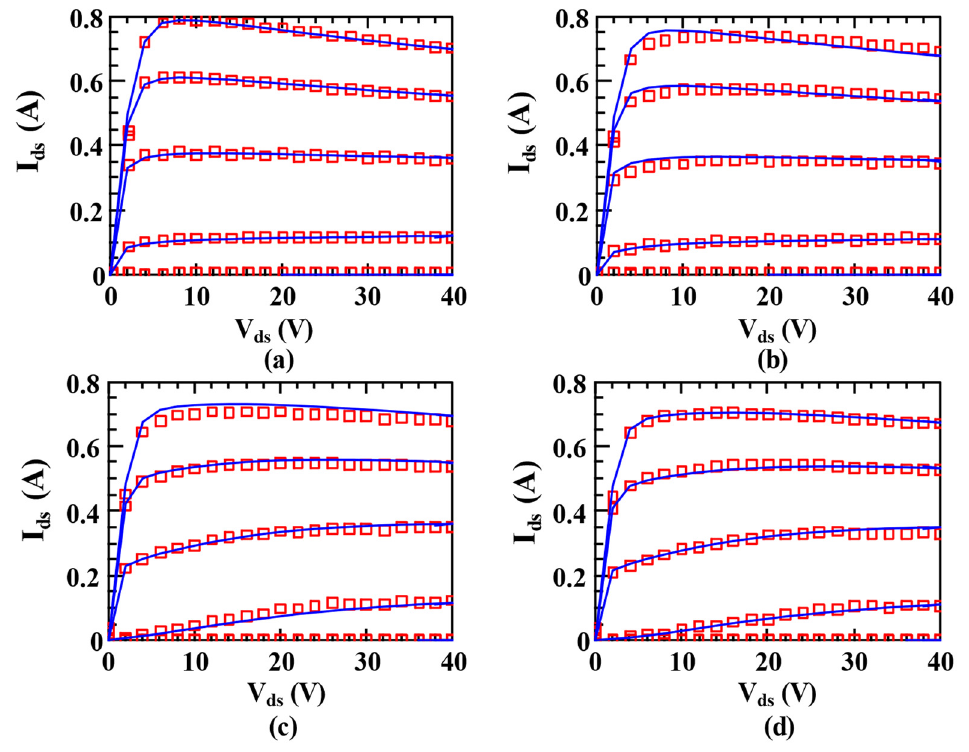
Figure 5. Measured (symbol) pulsed I DS − V DS data and modeled (line) pulsed I DS − V DS data using the trap model proposed in this paper under different quiescent bias at 25 ◦ C: ( a ) V gsq = 0 V, V dsq = 0 V; ( b ) V gsq = − 3 V, V dsq = 0 V; ( c ) V gsq = − 3 V, V dsq = 28 V; ( d ) V gsq = − 5 V, V dsq = 28 V. V gs ranges from − 4 V to 1 V with a step size of 1